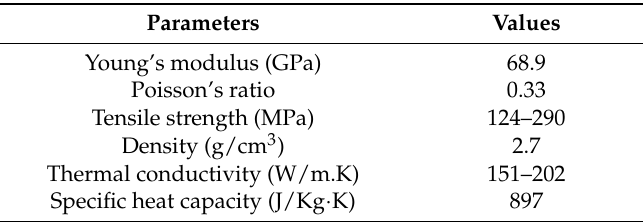
Table 2. Mechanical properties of workpiece material (Al 6061 alloys) used.